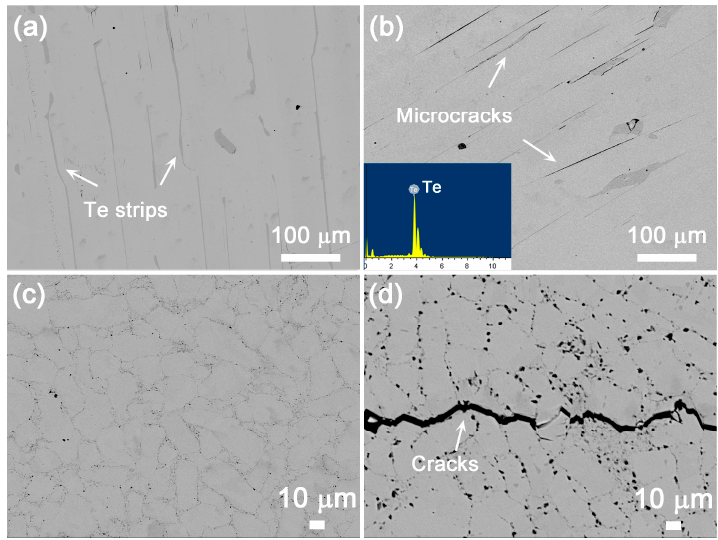
Figure 2. The BSE images of ZM and MS10 samples before and after annealing at 573 K: ( a ) unannealed ZM ingot; ( b ) annealed ZM ingots and MS10 samples; ( c ) before annealing; and ( d ) after annealing.